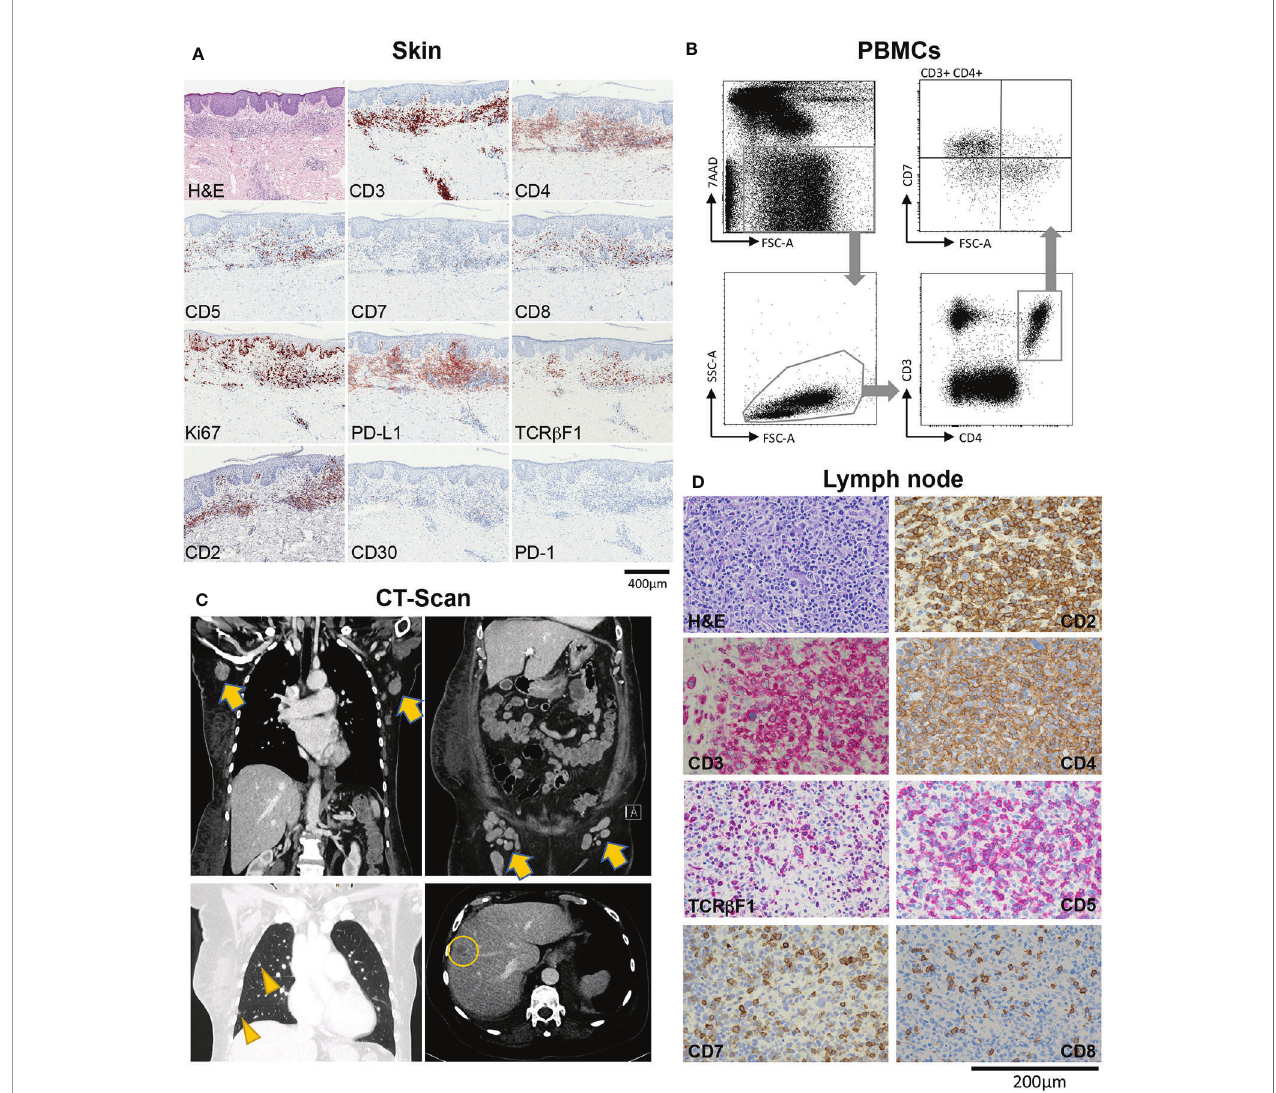
FIGURE 1 | Overview of a patient with advanced-stage mycosis fungoides (MF) with skin, blood, lymph node and internal organ involvement. (A) Histopathological evaluation of a skin biopsy showing an in fl ammatory in fi ltrate highly suspicious of MF, with T-cells showing partial loss of CD5, and total loss of CD7. (B) Flow- cytometric evaluation of peripheral blood mononuclear cells (PBMCs) showing a large T-cell population with CD7 loss within the CD3+CD4+ helper cell compartment. (C) Contrast-enhanced CT chest, abdomen and pelvis showing pathologically enlarged axillary and inguinal lymph nodes (arrows), and lesions to the lung (arrow heads) and the liver (circle) suspicious of CTCL manifestations. (D) Histopathological characterization of a diagnostic biopsy of an axillary lymph node, con fi rming CTCL